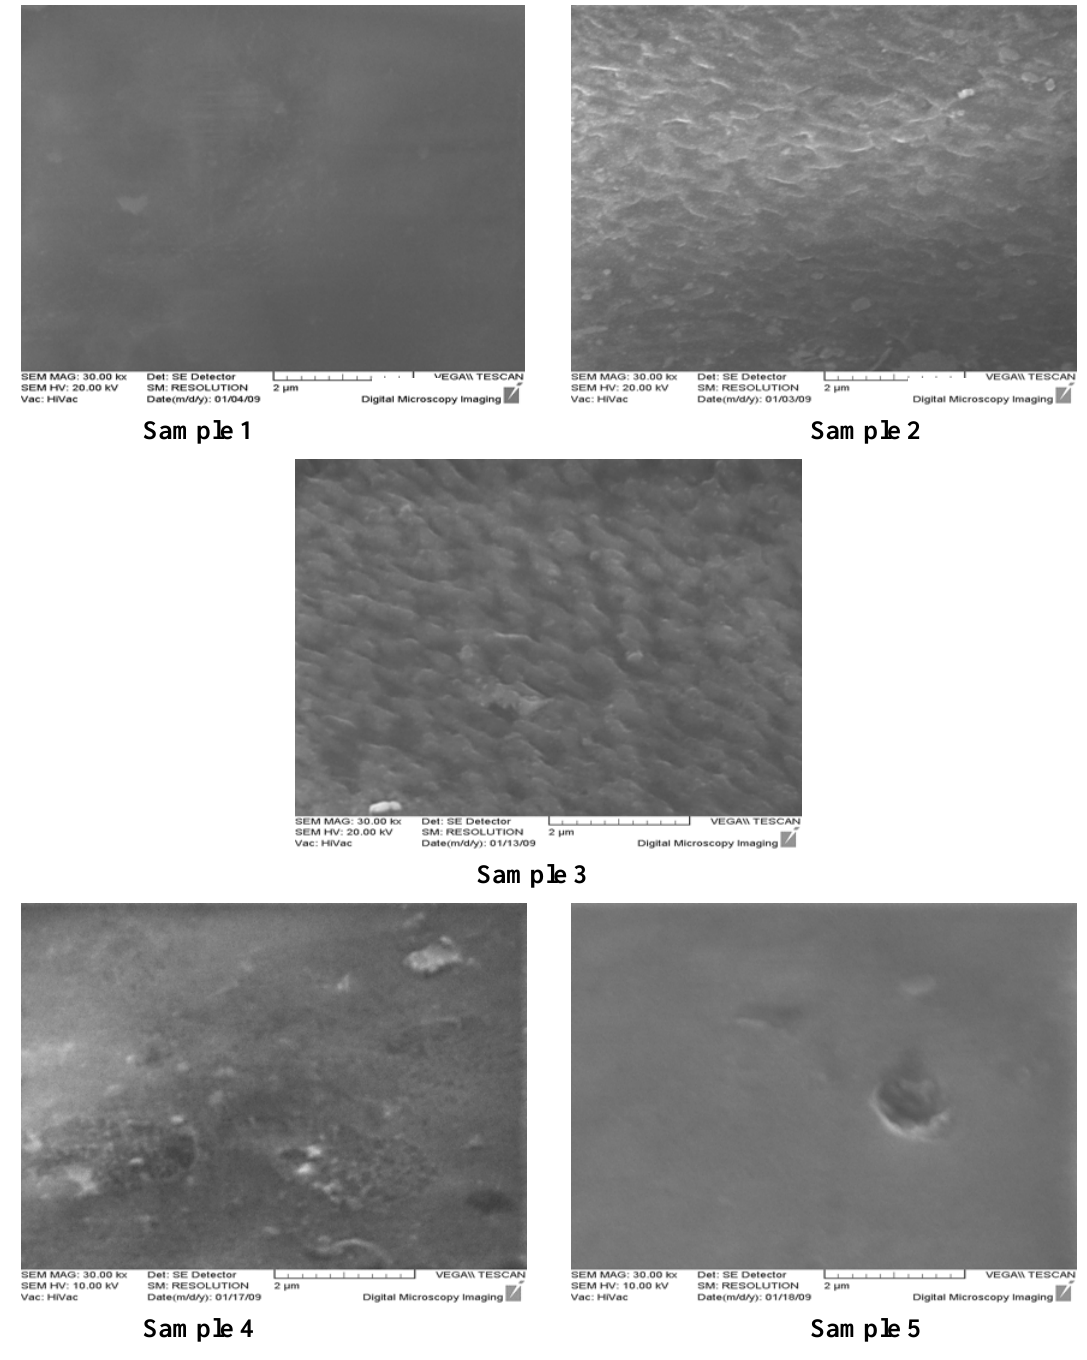
Figure 2. SEM micrographs of Samples 1-5 taken at 30 000 ×